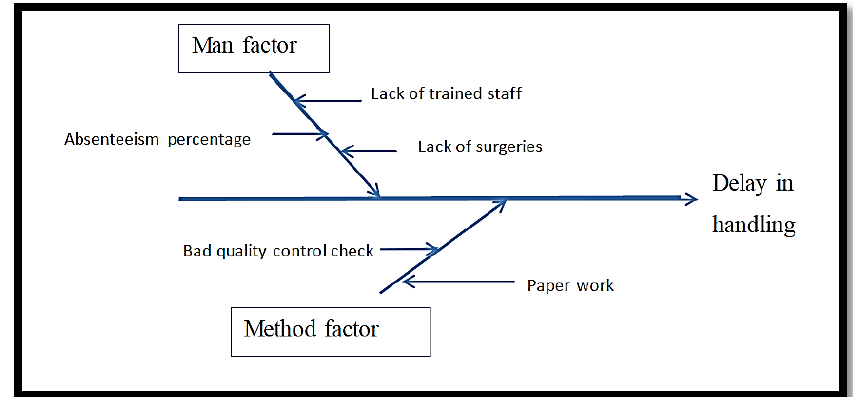
Fig. 12. Cause and effect diagram.